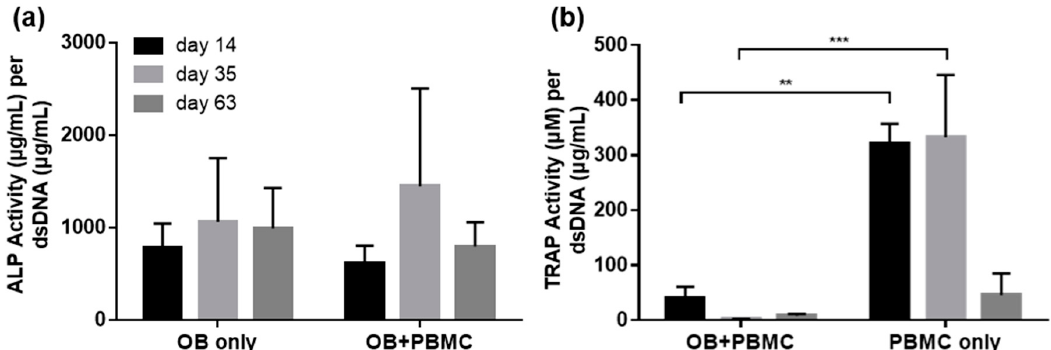
Figure 4. ( a ) Alkaline phosphatase (ALP) and ( b ) tartrate-resistant acid phosphatase (TRAP) activities of cells seeded on CaP-coated PCL scaffolds (mean ± SEM, N = 4 with n = 3 for each biological repeat). ** p < 0.05 and *** p < 0.01.